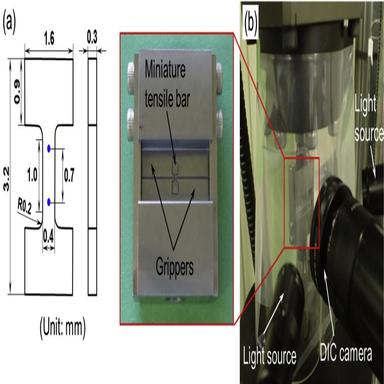
Miniature tensile test. (a) Dimensions of the miniature tensile bar, where the blue dots represent the locations for local displacement measurement; (b) testing frame.